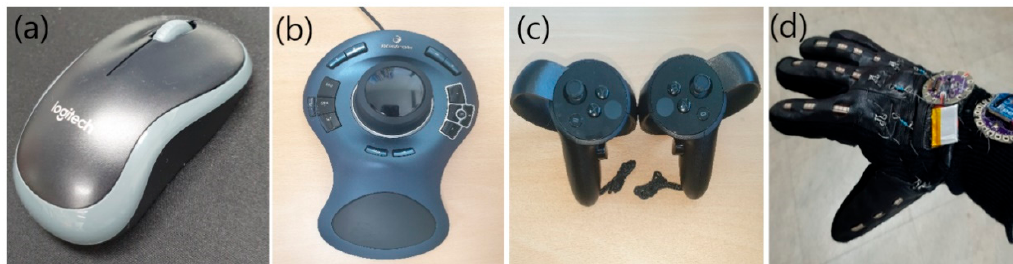
Figure 1. Three ‐ dimensional (3D) user interface devices used in this study. ( a ) Two ‐ dimensional (2D) mouse (M185, Logitech, Lausanne, Switzerland); ( b ) 3D mouse (Space Explorer, 3D Connexion, München, Germany); ( c ) virtual reality (VR) controller (Oculus Touch, Oculus, Irvine, CA, USA);